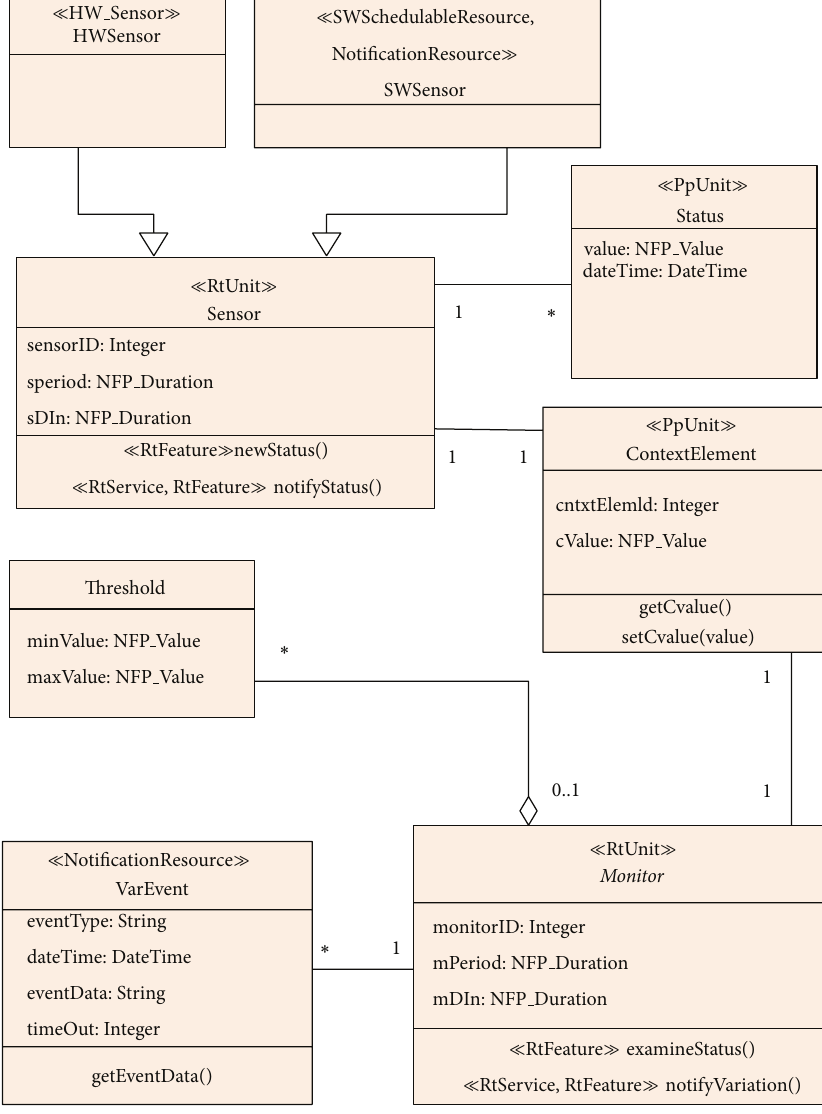
Figure 3: Structural view of the RTE Monitor